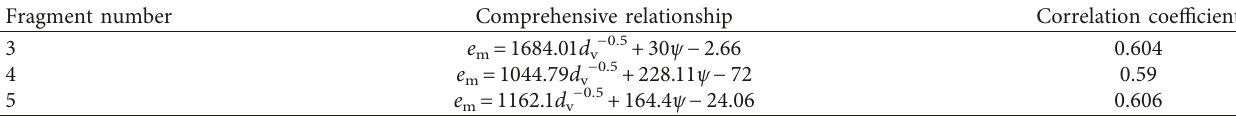
Table 1: Comprehensive relationship of specific breakage energy, sphericity, and initial